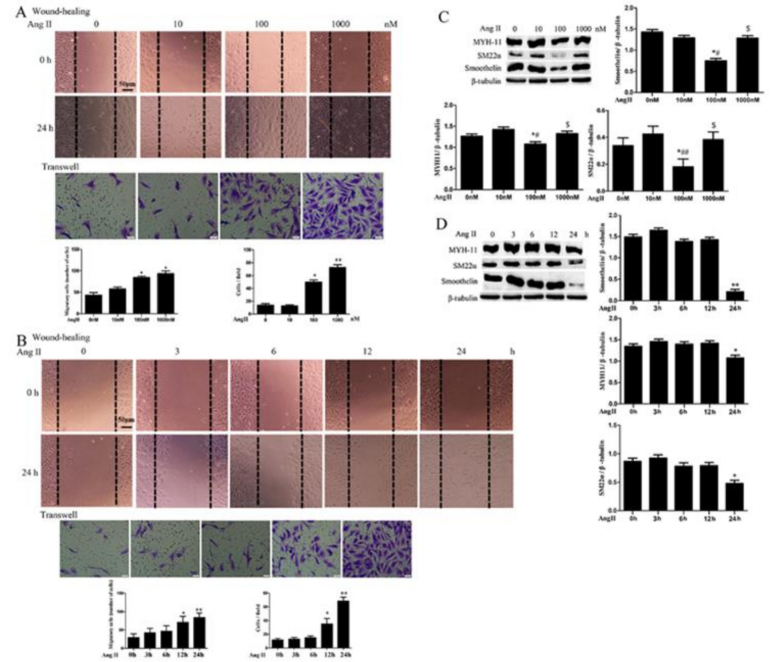
Figure 1. The effects of Ang II on cell migration and the expression of contractile marker proteins in human aortic vascular smooth muscle cells (HA-VSMCs). Cells were treated with Ang II at different concentrations (0, 10, 100, 1000 nM) or different time points (0, 3, 6, 12, 24 h). Untreated cells were used as the control. ( A , B ) Cell migration was detected by wound-healing and Transwell assays after Ang II treatment. Histograms show the quantification of the wound healing and Transwell assay results. The scar bar is 50 µ m. * p < 0.05 and ** p < 0.01 vs. the control group ( n = 3). ( C , D ) Western blot analysis of MYH11, SM22 α , and smoothelin. Histograms show the ratios of myosin heavy chain (MYH11) or SM22 α or smoothelin to β -tubulin. * p < 0.05 and ** p < 0.01 vs. the control group; # p < 0.05 and ## p < 0.01 vs. the group treated with 10 nM Ang II; $ p < 0.05 vs. the group treated with 100 nM Ang II ( n = 3).